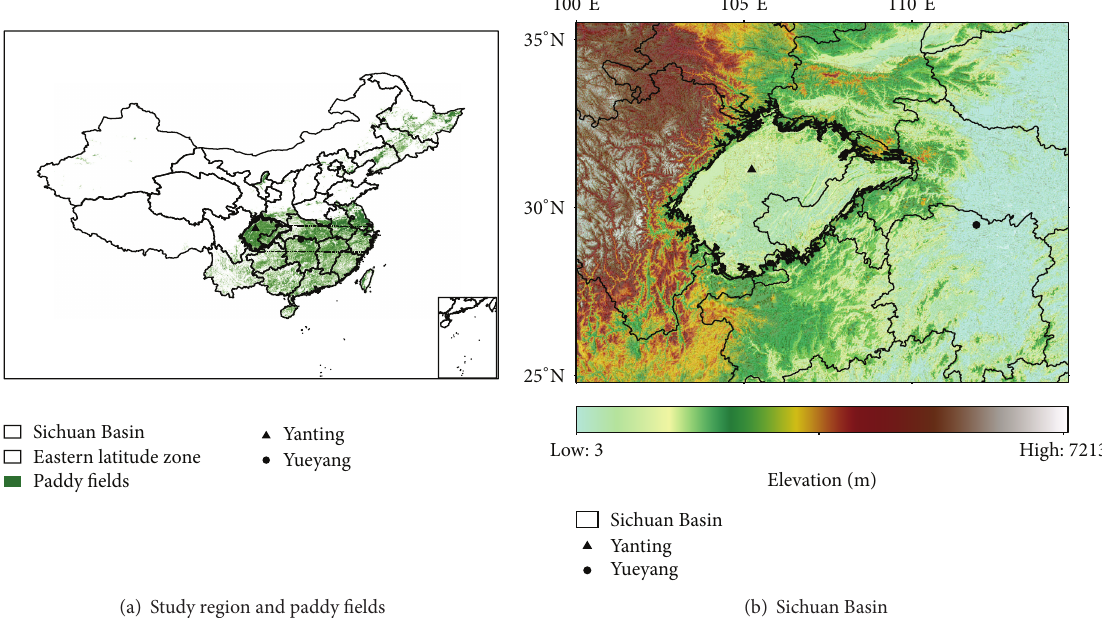
Figure 1: (a) Paddy fields distribution in China, the Sichuan Basin (black line polygon), and the comparative study regions (within two horizontal lines) at the same latitude zone to the east of the basin, and (b) the terrain elevation of the Sichuan Basin. Also showed in (a) and (b) are the locations of Yanting (solid triangle) and Yueyang (solid